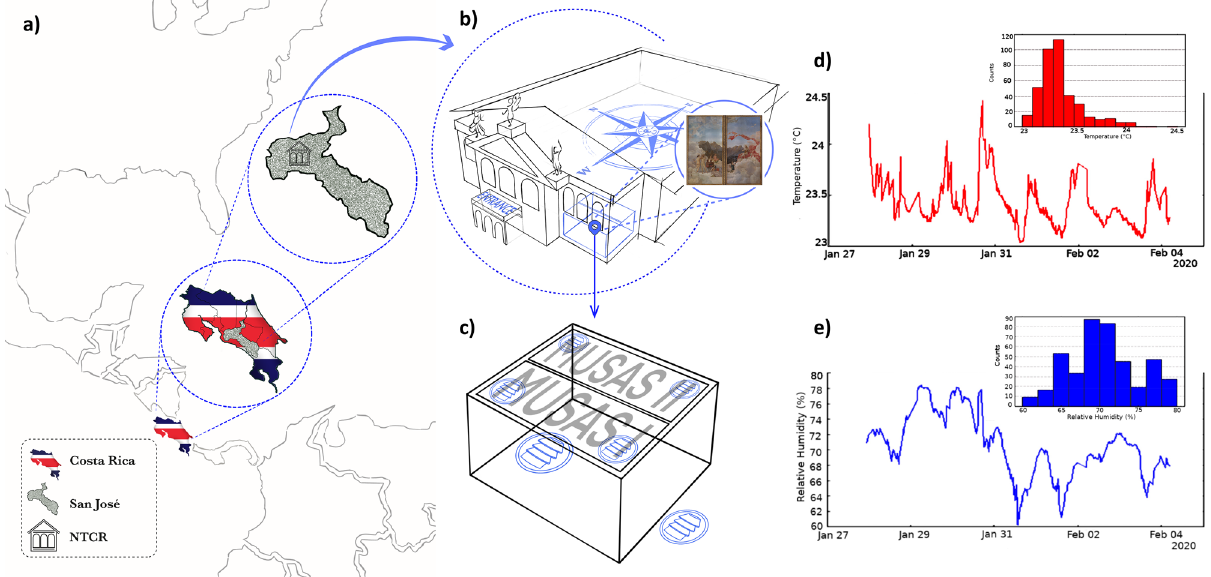
Figure 8. Conservation in the tropics: Monitoring the paintings’ environment. ( a ) National Theatre of Costa Rica in San José (NTCR), Costa Rica, Central America. ( b ) Musas I and Musas II are located on the ceiling, at a height of about 3.5 m in the men’s canteen on the ground floor of the Theatre. ( c ) Location of the environmental sensors. (d) Temperature and ( e ) humidity variations in the paintings’